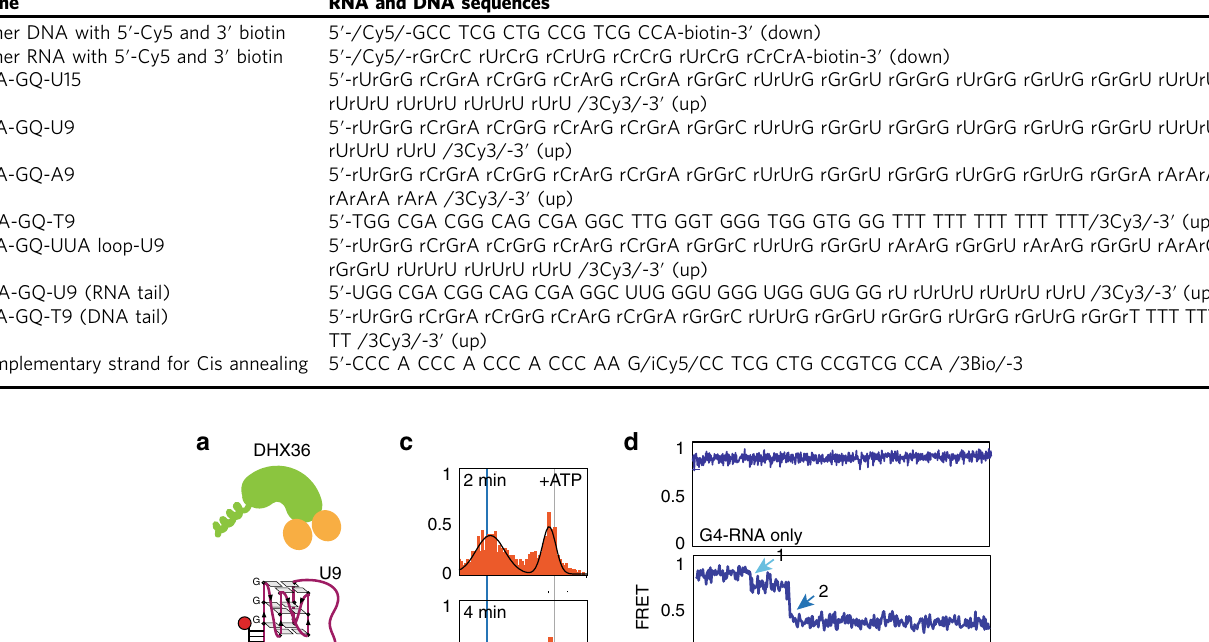
Table 1 Sequences of RNA and DNA used in the study Name RNA and DNA sequences 18mer DNA with 5 ′ -Cy5 and 3 ′ biotin